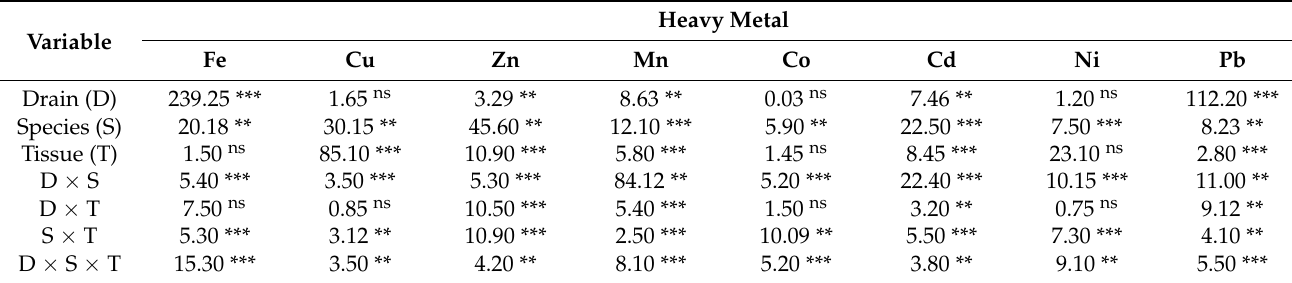
Table 2. Results of three-way analysis of variance assessing the effect of the drain (three drains), species (seven species), and tissues (aboveground and belowground) on the detected heavy